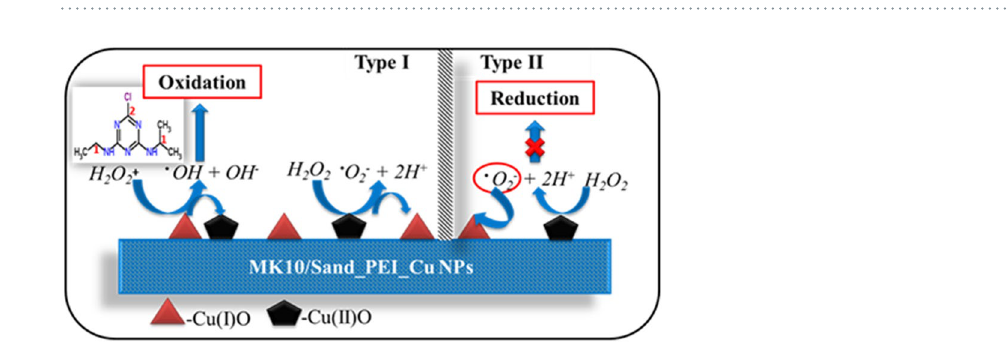
Figure 8. First-order kinetic ( a ) and second-order kinetic ( b ) models of atrazine degradation by modified MK10 and sand.